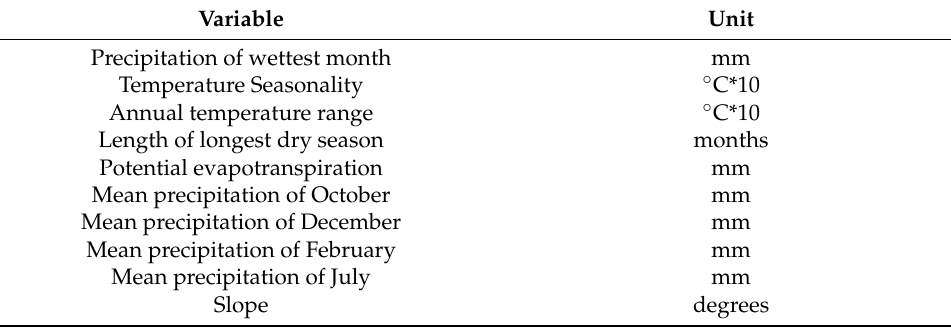
Table 1. Variables fitted in BRT algorithm for niche